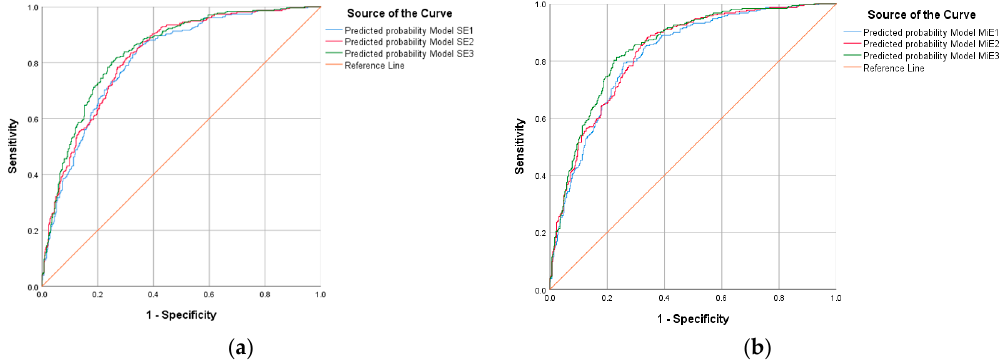
Figure 1. Receiver operating characteristic (ROC) curve: ( a ) for SE models; ( b ) for MiE models. Table 2. Area under the curve (for SE and MiS